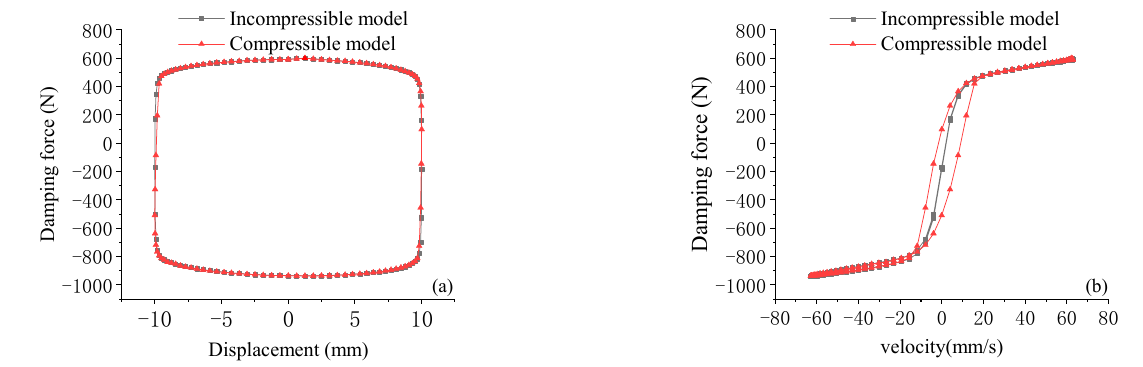
Figure 10. Damping characteristic contrast considering compressibility and incompressibility: ( a ) damping force–displacement; and ( b ) damping force–velocity.